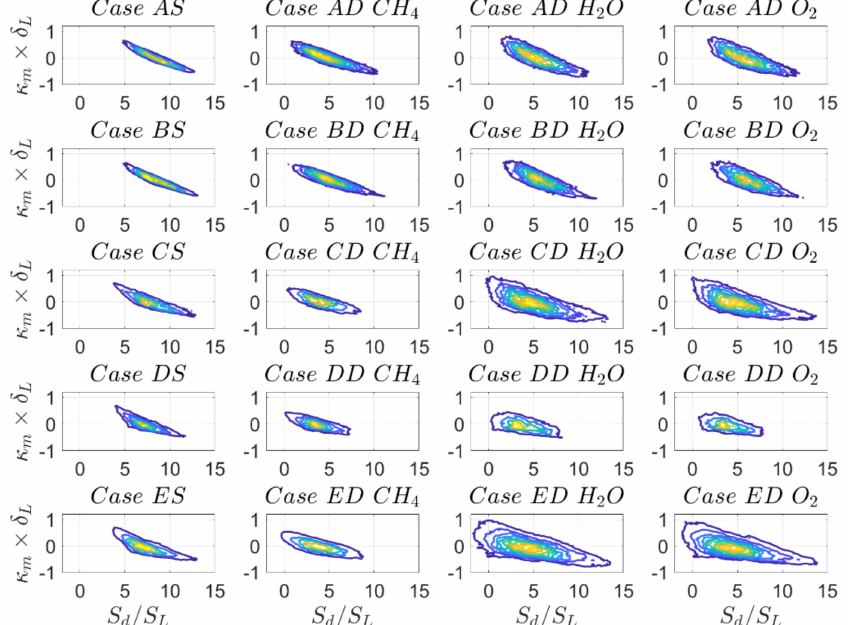
Figure 12. Joint PDF of normalised displacement speed S d / S L and normalised mean curvature κ m × δ L on c = 0.8 progress-variable isosurface for top to bottom cases A–E for (1st column) SC and (2nd to 4th column) DC simulations for reaction progress variable based on CH 4 , H 2 O,O 2 mass fractions.